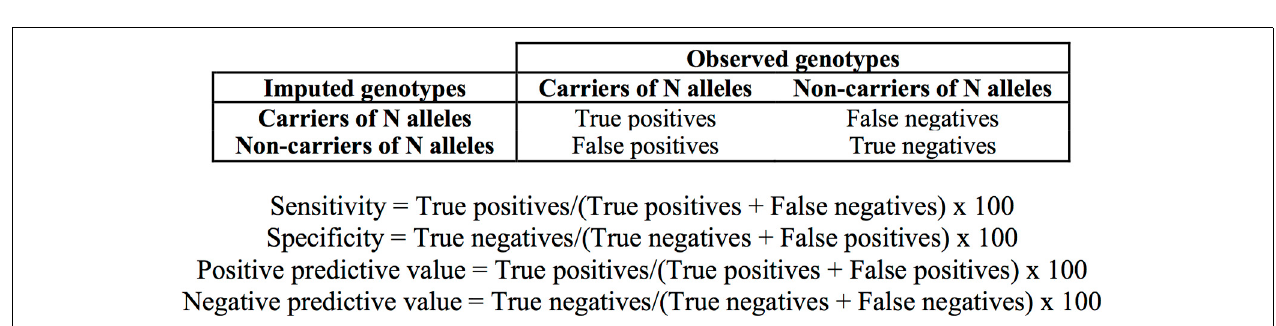
classified as Hispanics (19 out of 33), 15.15% as Asians ( N = 5) and Caucasians ( N = 5) and 12.12% as African Americans ( N =